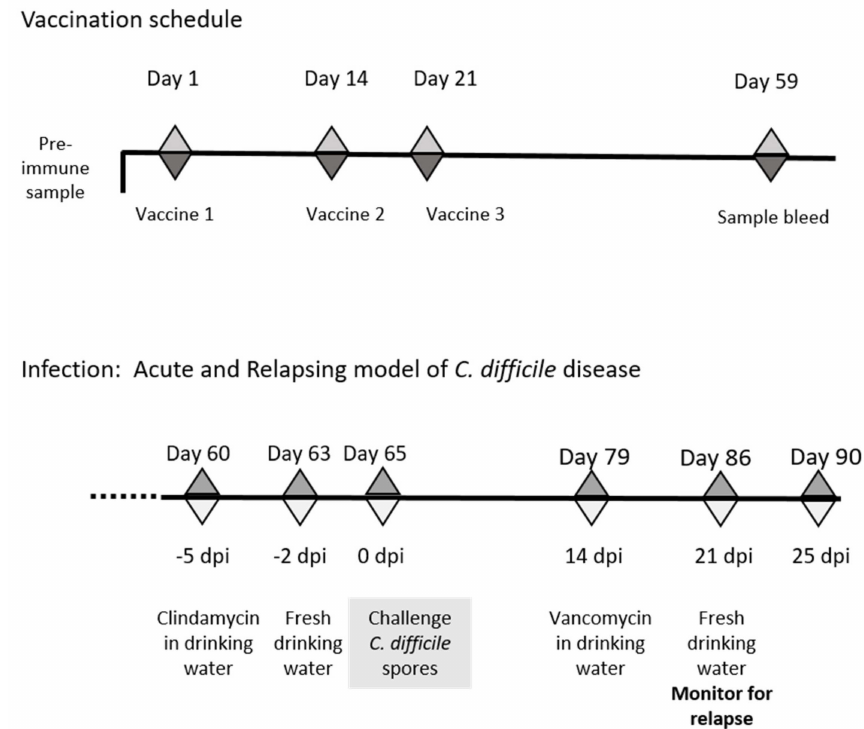
Figure 1. Schematic of schedule of vaccination and antibiotic treatments used to establish acute and relapsing C. di ffi cile disease in mice. The vaccination schedule highlights the days vaccines were given and sample bleeds taken for immune evaluation, whilst the infection schedule indicates the timing of antibiotic treatments and C. di ffi cile